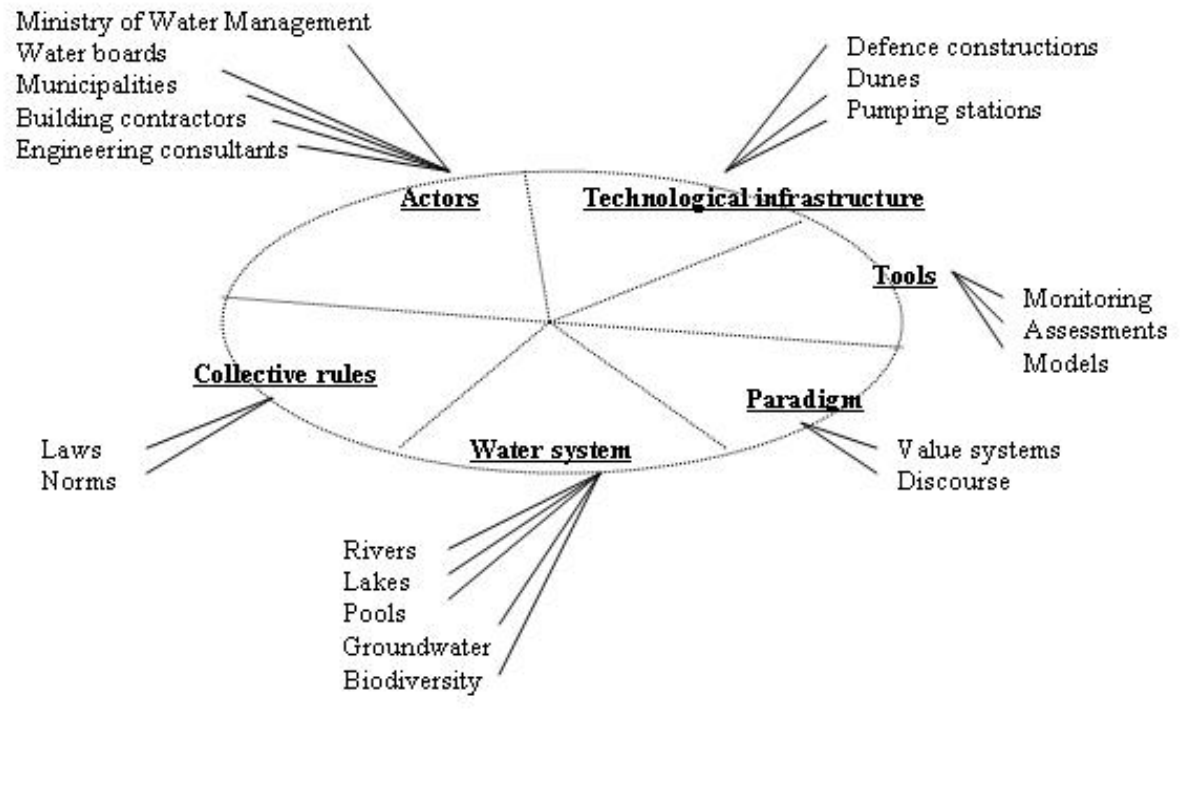
Fig. 1. Schematic conceptualization of the Dutch water management regime. The regime refers to the web of actors, pardigms, collective rules, infrastructure, and tools. There is a powerful alignment and internal logic between elements, which both enable and constrain interventions in the water